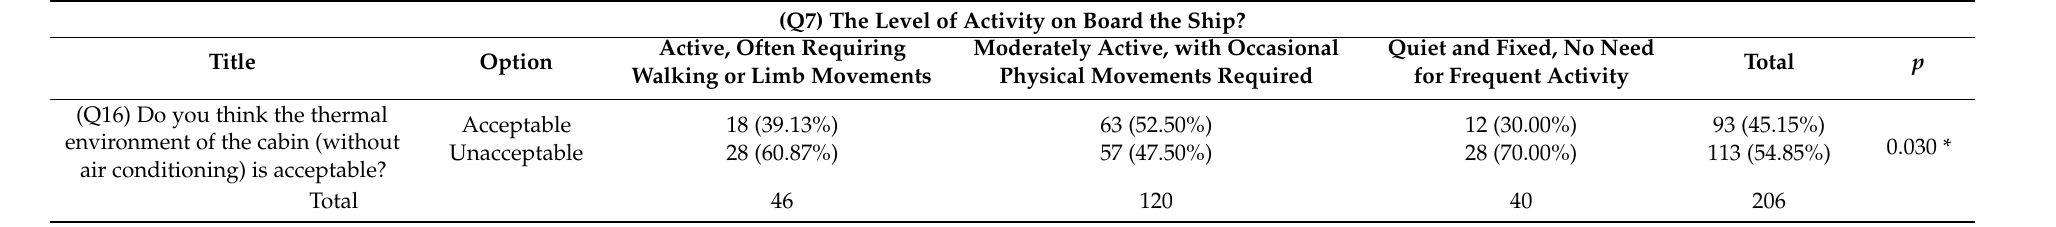
Table 4. Questionnaire for activities and thermal tolerance.